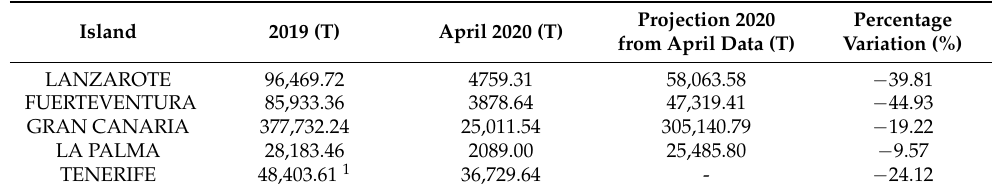
Table 2. Variation in production of mixed municipal waste fraction based on April 2020 data in tons [35].